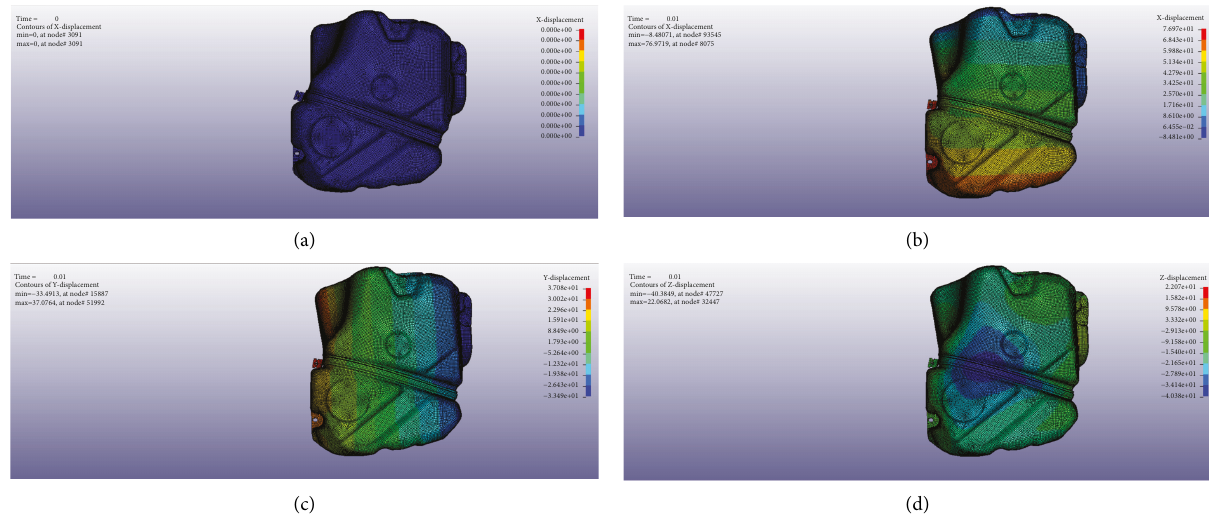
Figure 3: Displacement diagram of the fuel tank. (a) Before the collision. (b) Displacement diagram in the x -direction after the collision. (c) Displacement diagram in the y -direction after the collision. (d) Displacement diagram in the z -direction after the collision.